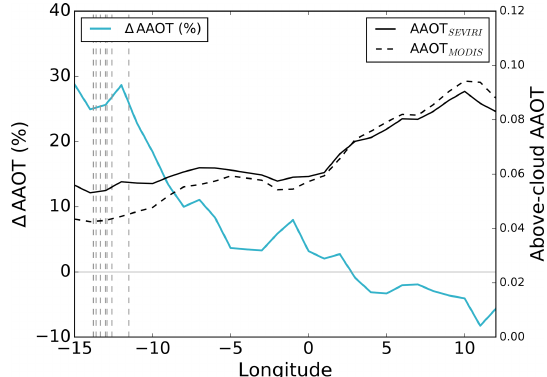
Figure 7. Longitudinal variation in the above-cloud AAOT from SEVIRI (black solid line), MODIS (black dashed line) and the dif- ference (cid:49) AAOT in percentage (blue line) for the data used in Fig. 3, removing AAOT SEVIRI lower than 0.03. The dashed vertical lines correspond to the location of the dropsondes used in Fig.